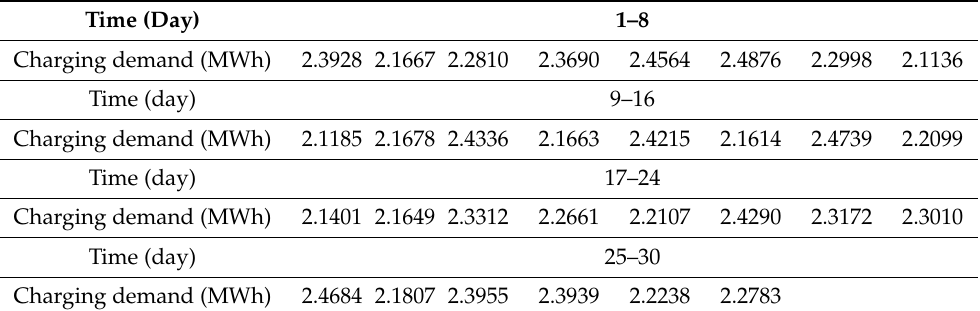
Table 3. Historical raw data of the total energy charging demand of HEVs over a month in the microgrid.